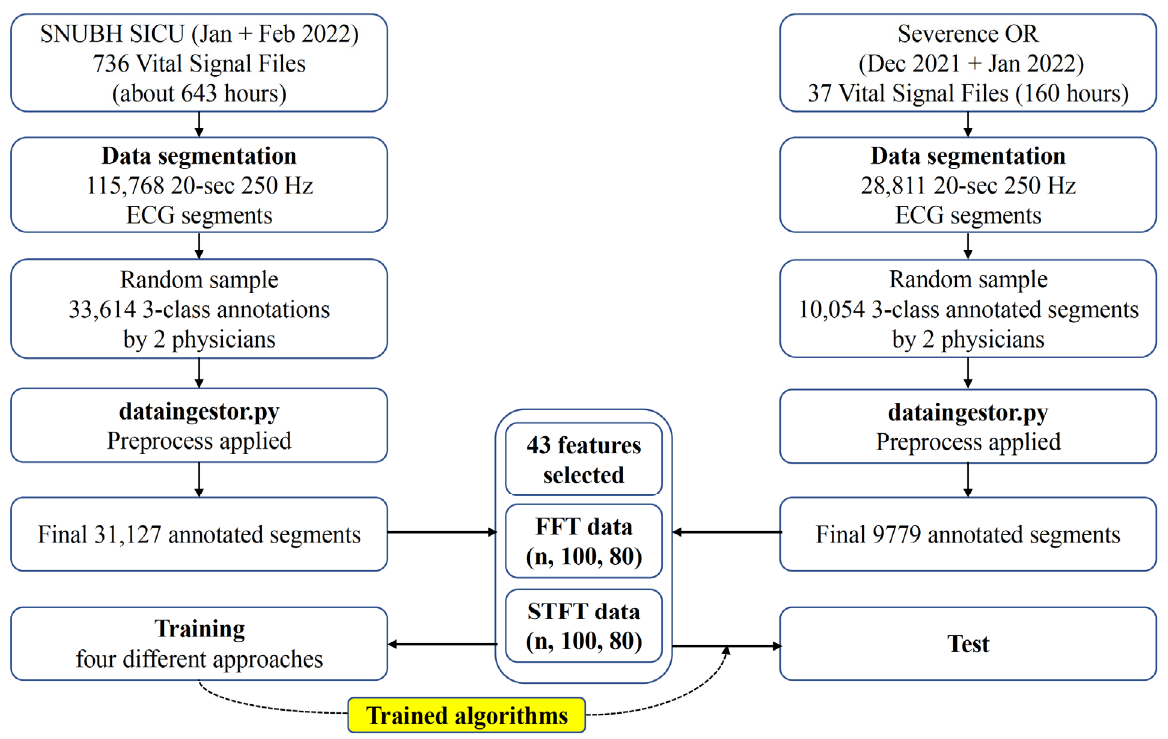
Figure 1. Architecture of the study. SNUBH: Seoul National University Bundang Hospital; ECG: electrocardiography; OR: operating room; FFT: fast Fourier transformation; STFT: short-time Fourier transformation.